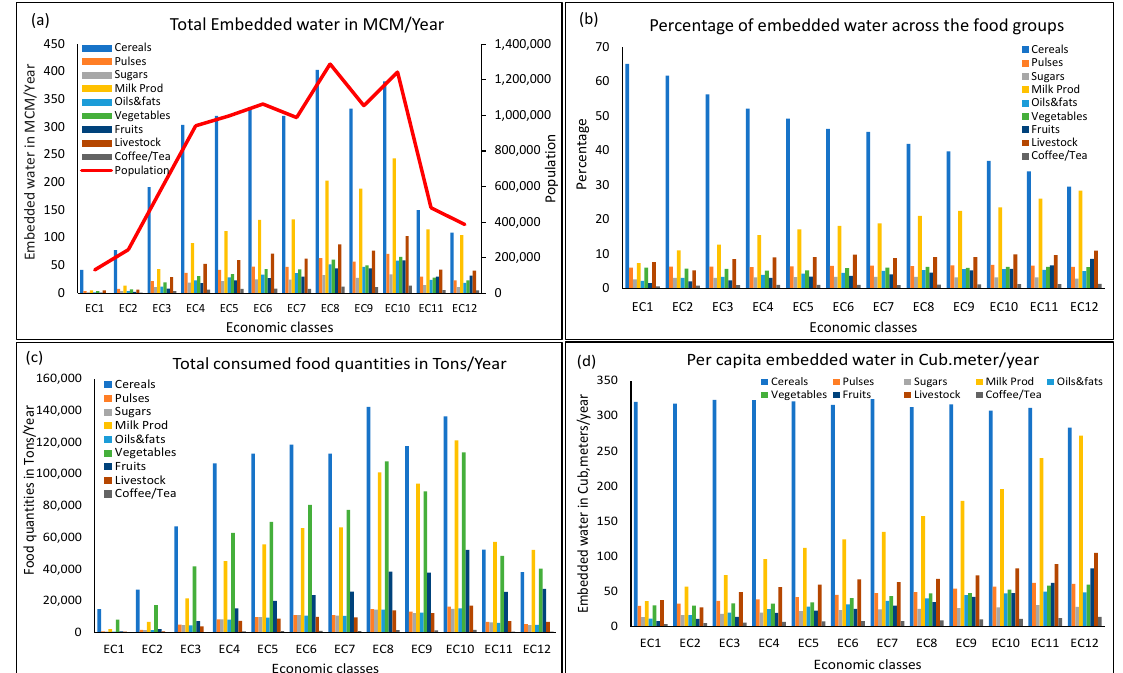
Figure 4. Total embedded water for each food group and each economic class, the plots also have population information on the right side of y-axis ( a ); similar to ( a ), but for the percentage equivalent of embedded water ( b ); similar to ( a ), but for total consumed food quantities ( c ); and similar to ( a ), but for per capita embedded water ( d ). The food group of fruits held the second-lowest embedded water content in